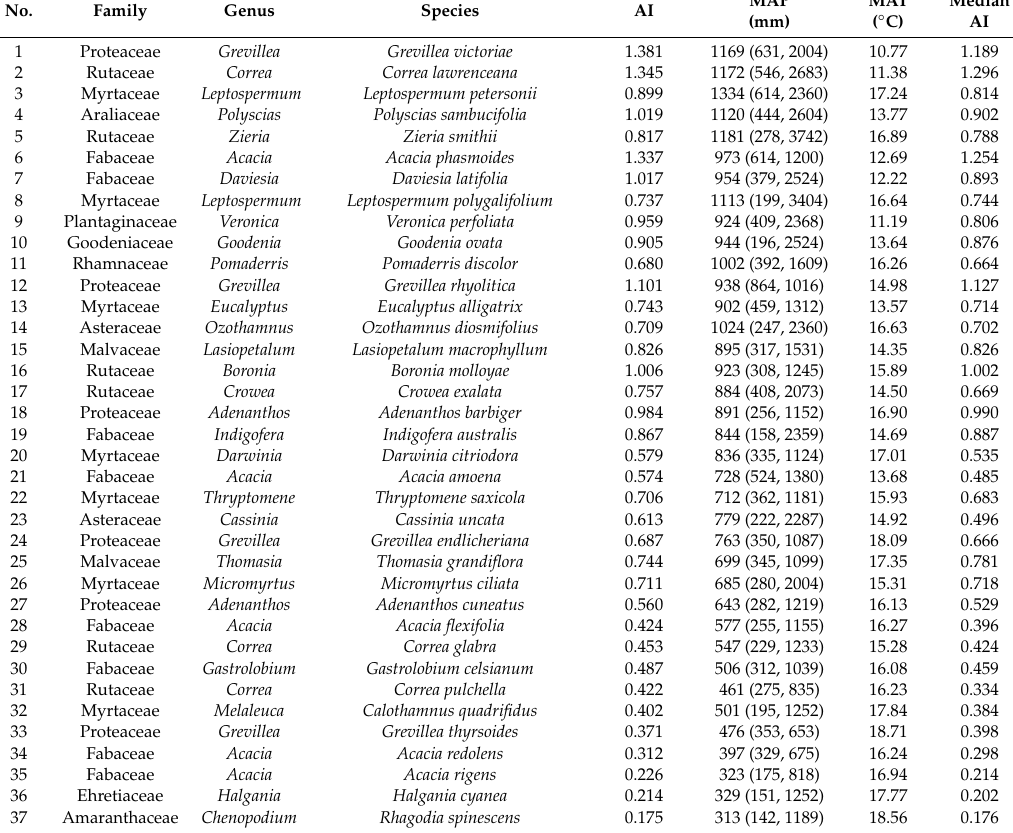
Table 1. Climates of origin for each shrub species grown in the common garden; mean annual precipitation (MAP), mean annual temperature (MAT) with the range, and mean annual heat-moisture index (HMI). Rows are ordered by ascending HMI at the origin of